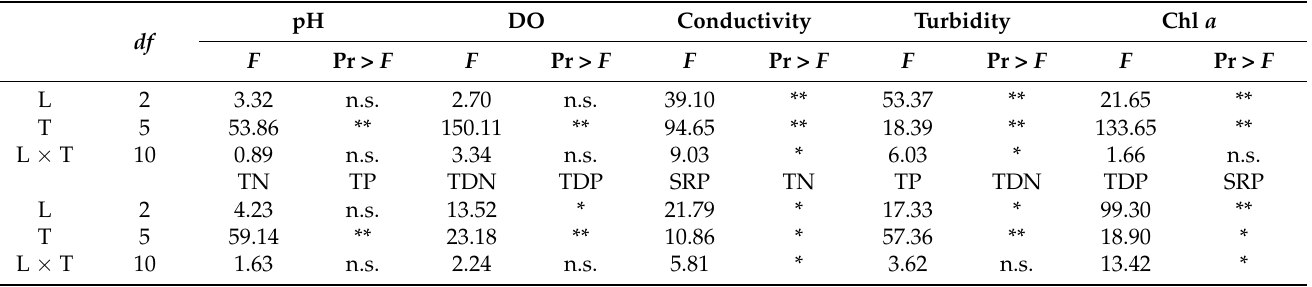
Figure 1. Time series of pH ( a ), dissolved oxygen (DO) ( b ), conductivity ( c ), and turbidity ( d ) in different treatments. Factor was LMB (0, 425 g m − 2 , and 850 g m − 2 ). The values represented a standard deviation ( n = 4). Table 1. rANOVA results of the physicochemical parameters in the overlying water during the